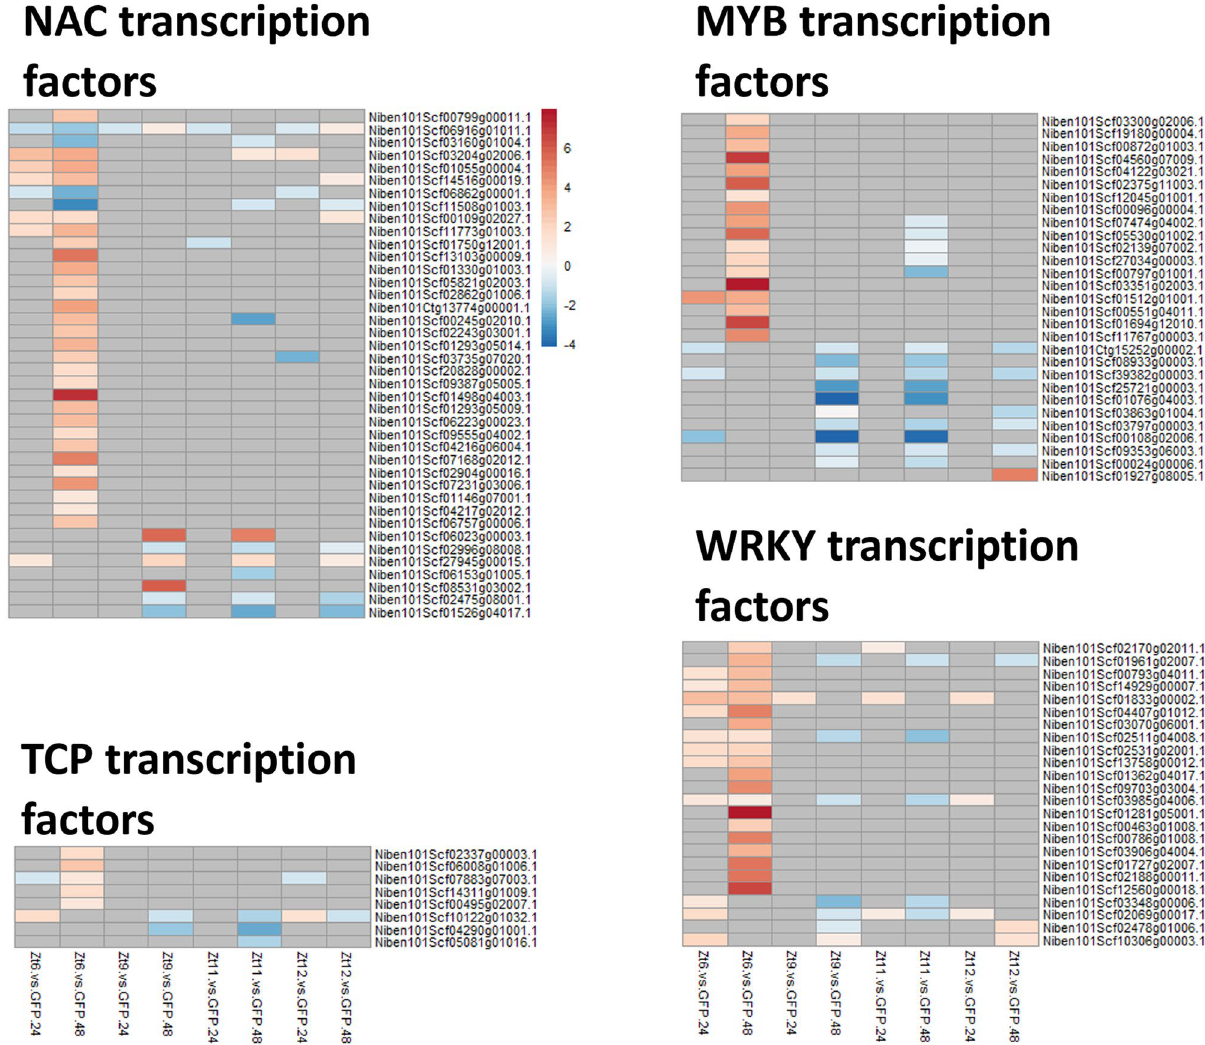
Figure 6. Expression profile of senescence regulating transcription factor genes with marked difference in expression change between Zt6 and Zt9, Zt11, and